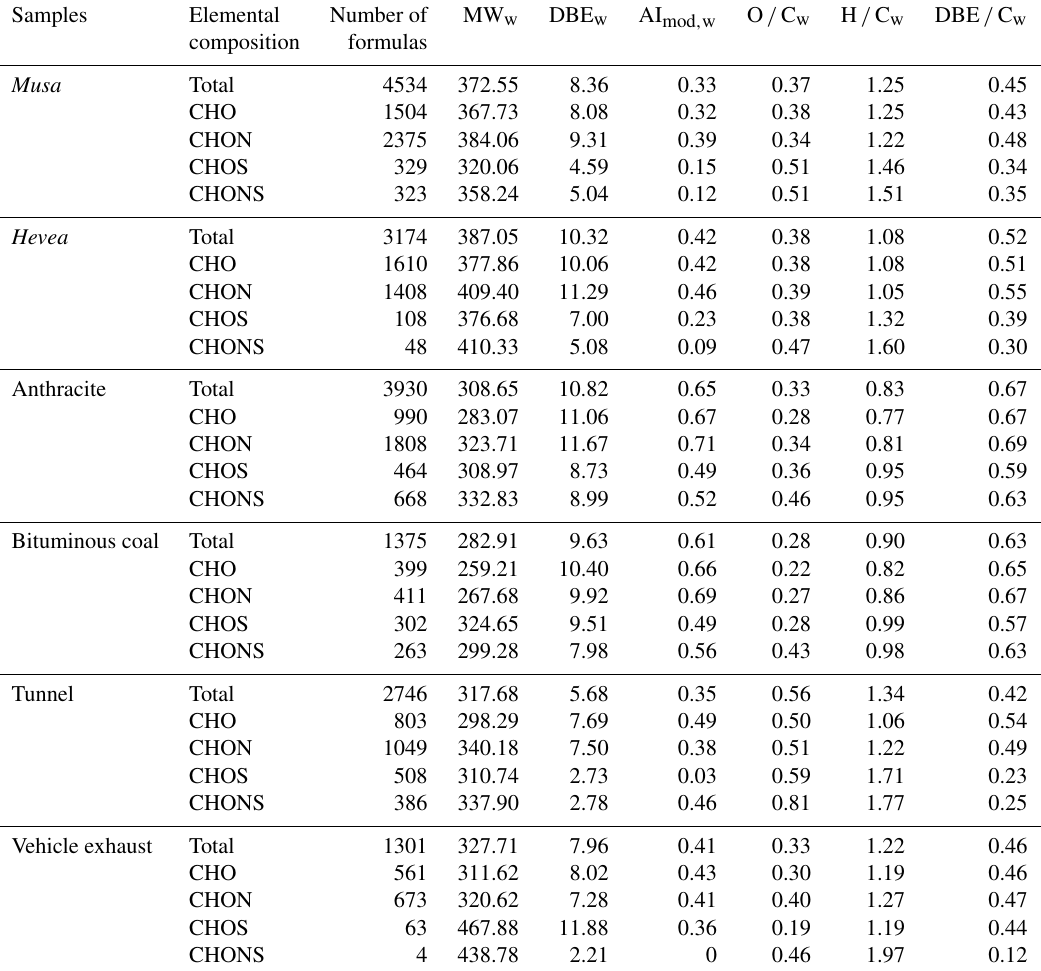
Table 2. Number of formulas in each compound category and the average values of elemental ratios, molecular weight (MW), double-bond equivalents (DBE), and modified aromaticity index (AI mod ) in WSOC from the six aerosol samples.